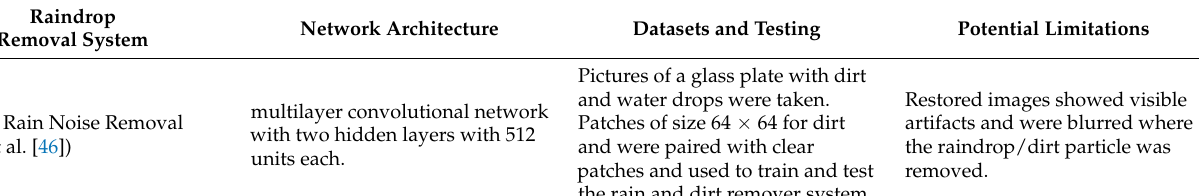
Table 6. Deep Learning and CNN Approach to Image